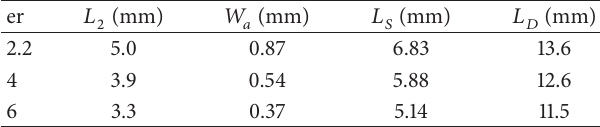
Figure 6: Cross-polarized level versus frequency with different relative permittivity. Table 1: Dimensions vary with the relative permittivity.